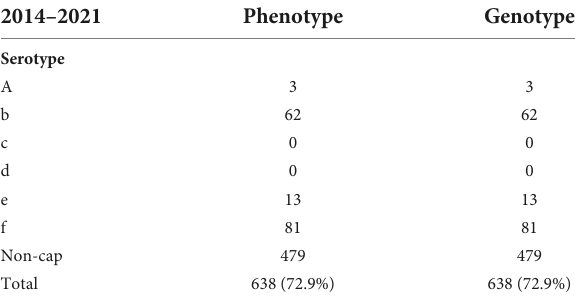
TABLE 3 A total of seven hundred and thirteen invasive cases of Haemophilus influenzae were reported in Denmark from 2014 to